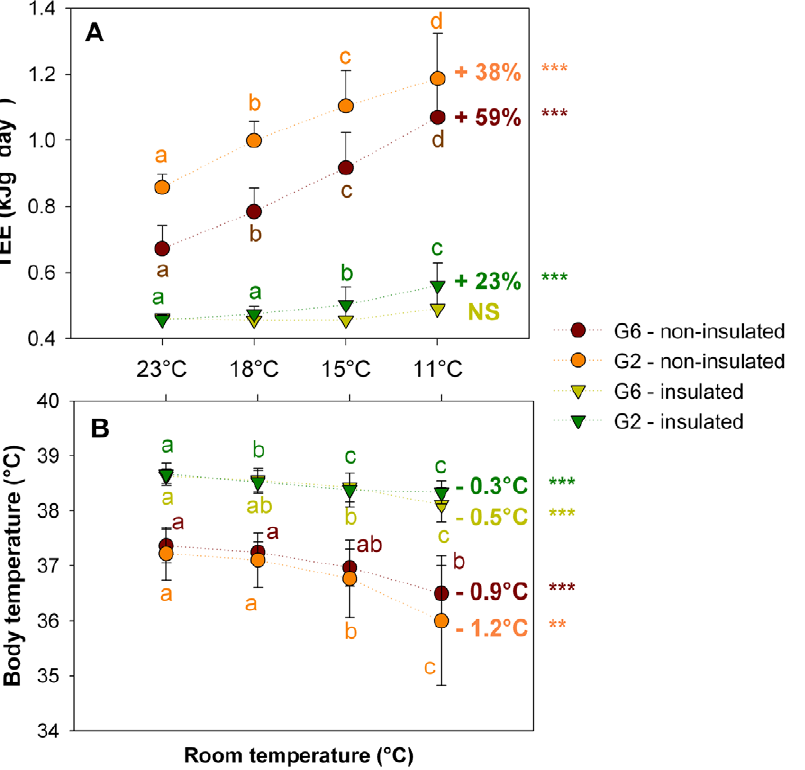
Figure 1. Relationship between total energy expenditure (TEE) and body temperature of insulated and non-insulated pups, huddling in groups of 6 (G6) or placed in groups of 2 (G2), during the cold challenge. Different letters indicate significant differences. ***: significant differences with p , 0.0001 between 23 u C and 11 u C; **: significant differences with p , 0.002 between 23 u C and 11 u C. NS: not